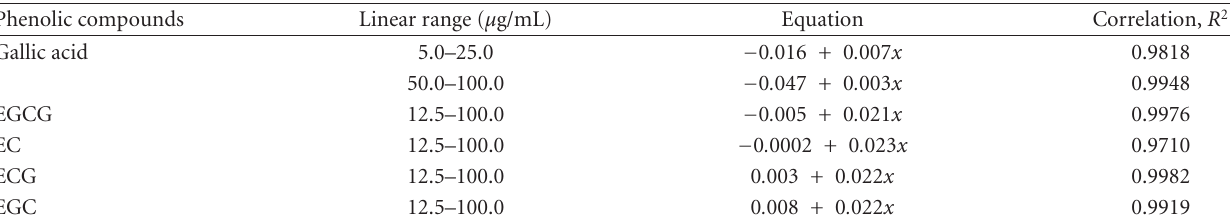
Table 2: Parameters of regression for phenolic compounds.